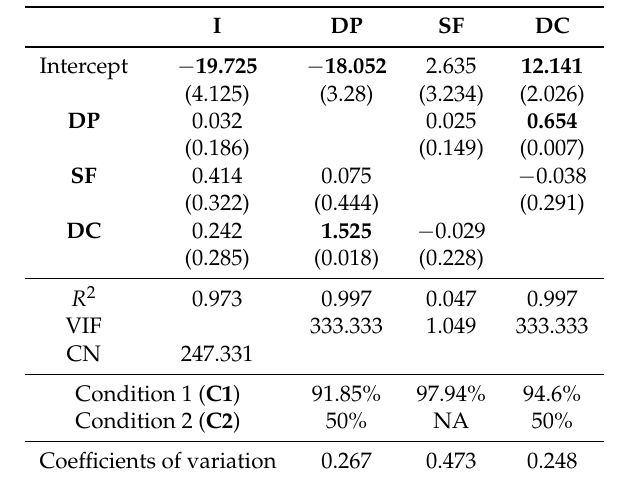
Table 12. Estimations by OLS of Model (14) and its corresponding auxiliary regressions (estimated standard deviation in parenthesis and coefficients significantly different from zero in bold).